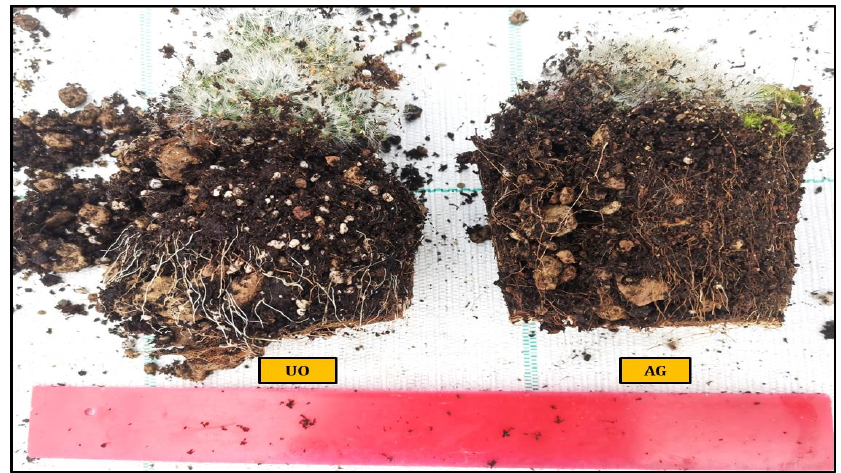
Figure 3. Comparison of root growth in Mammillaria prolifera plants treated with Ulva ohnoi (UO) and Ecklonia maxima ( AG).